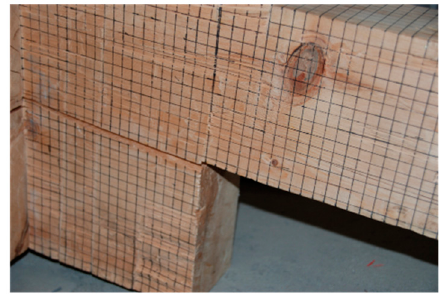
Figure 19. Compression deformation of the tenon.